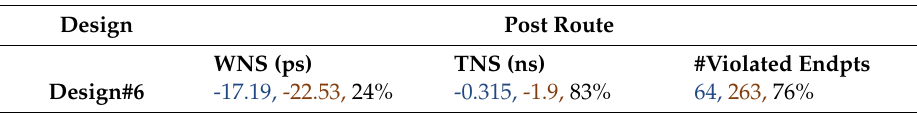
Table 8. Post-route timing closure on